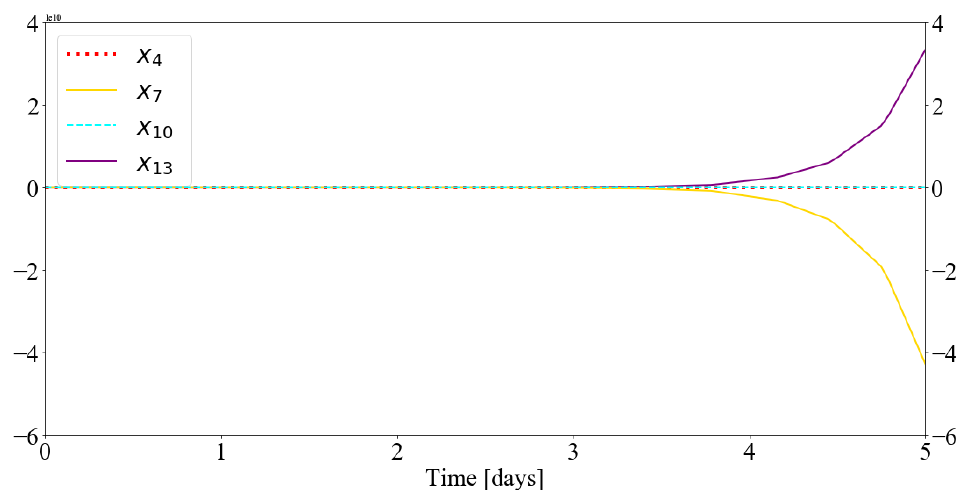
Figure 8. Sensitivity functions x 4 , x 7 , x 10 , and x 13 are the sensitivities x 1 with respect to λ 1 , λ 2 , λ 3 , and λ 4 in time, respectively. The simulation was computed for the initial state x 1 = 0.03047. The solution is more sensitive to variations in the parameters λ and x 3 0 λ 4 = zc 0 than to variations in the parameters λ 1 = ρ m and λ 3 = µ m . We performed the simulation and plotting in Octave 5.1.0.0 and Python 3.7.1, respectively.